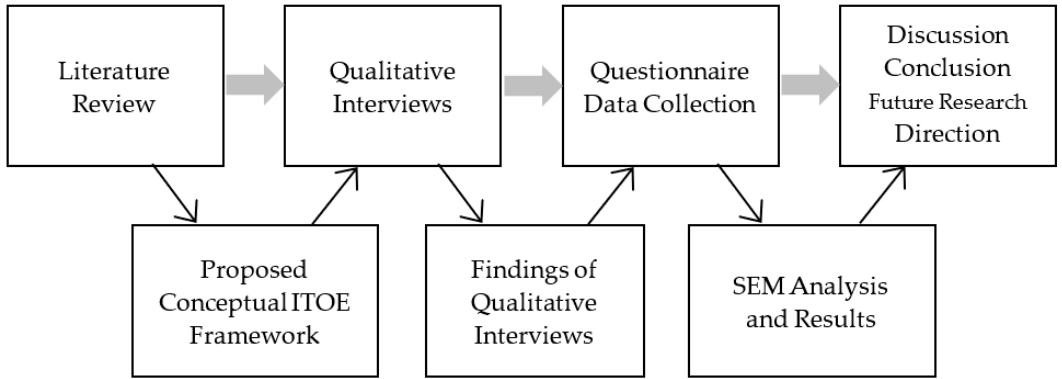
Figure 1. Research methods and process.